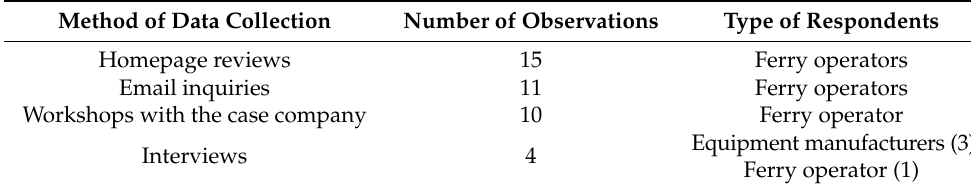
Table 2. Observations and method